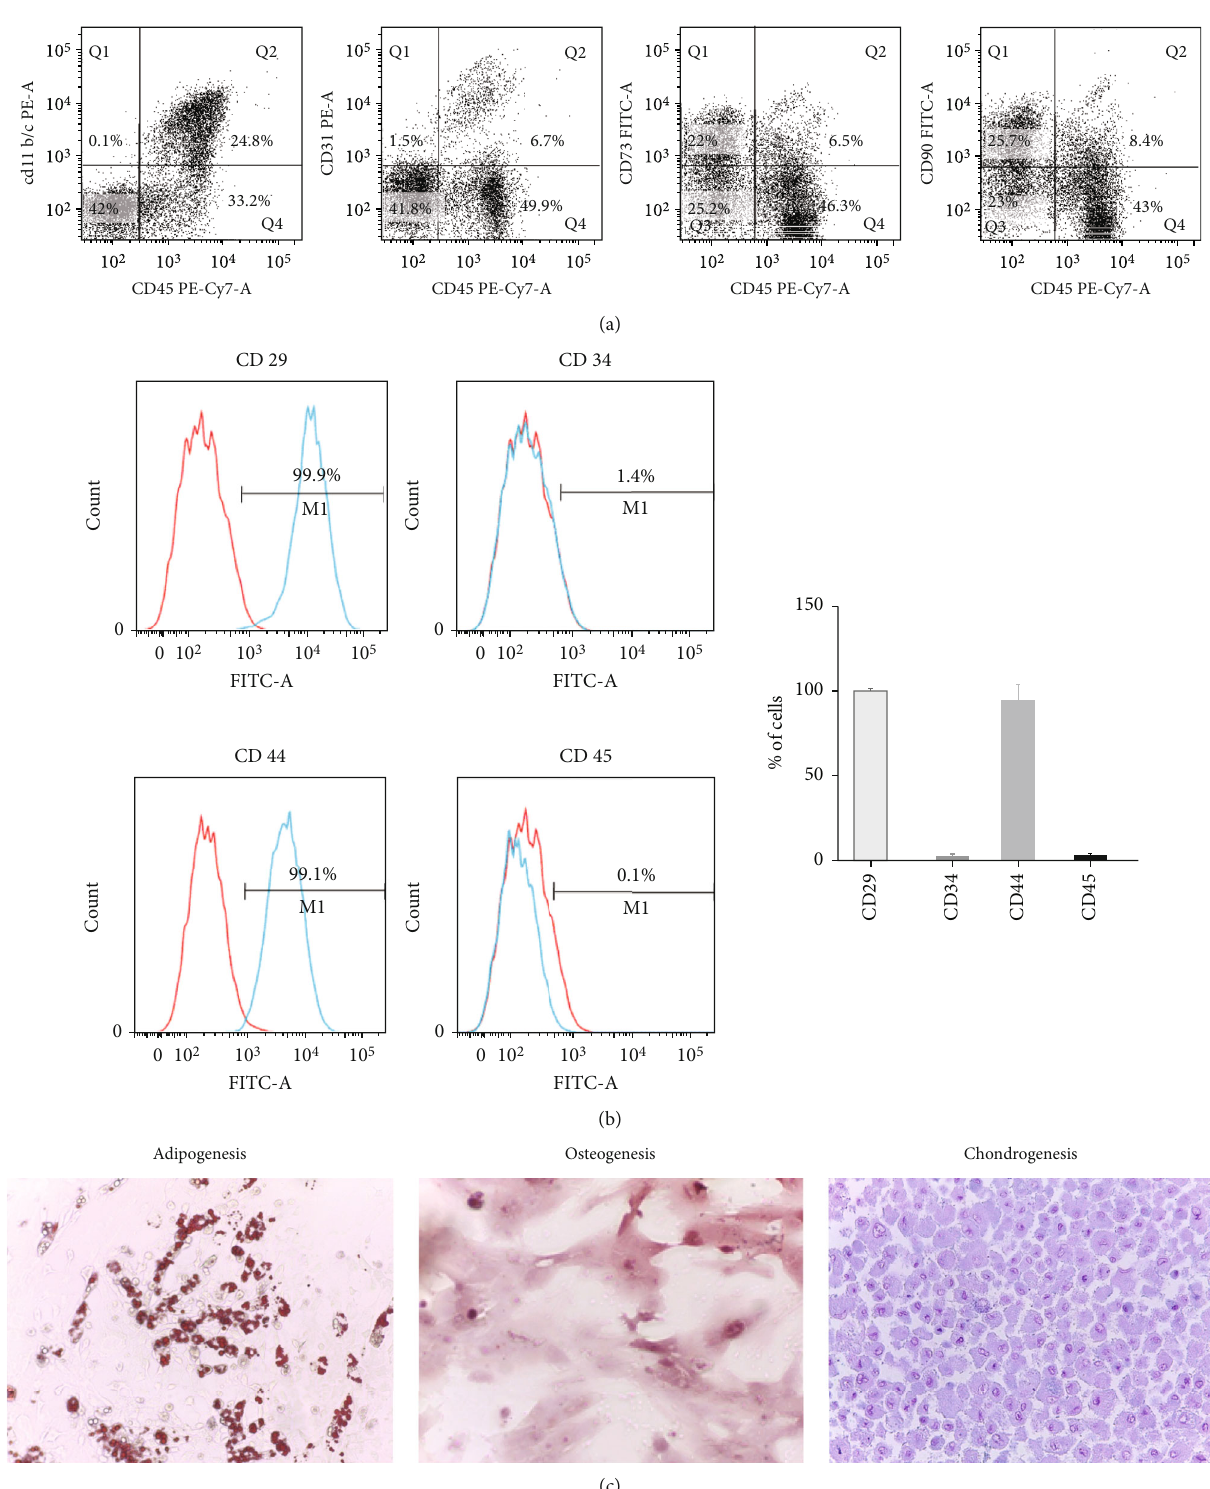
Figure 1: Characterization of SVF and ADSC. (a) Representative fl ow cytometry histograms of SVF. 1 time using SVF collected from 3 rats, 3 rats per each SVF group. (b) Flow cytometry of ADSC. Results were expressed as mean ± standard error of all independent experiments. 3 times per rat, 3 rats per each ADSC group. (c) Appearance of ADSC after 3 weeks of induction of adipogenic, osteogenic, and chondrogenic di ff erentiation. Magni fi cation, × 100 in adipogenesis and osteogenesis and × 400 in chondrogenesis. 3 times, 3 rats per each ADSC